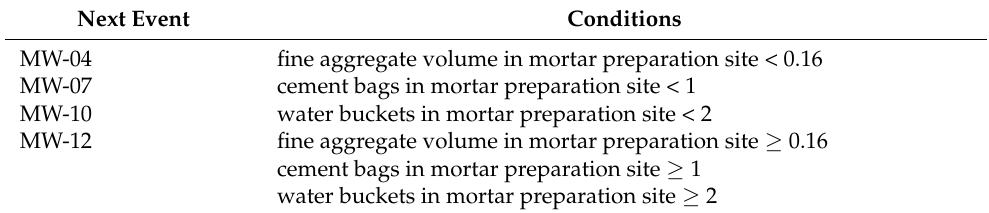
Table 3. Decision making mechanism of control unit